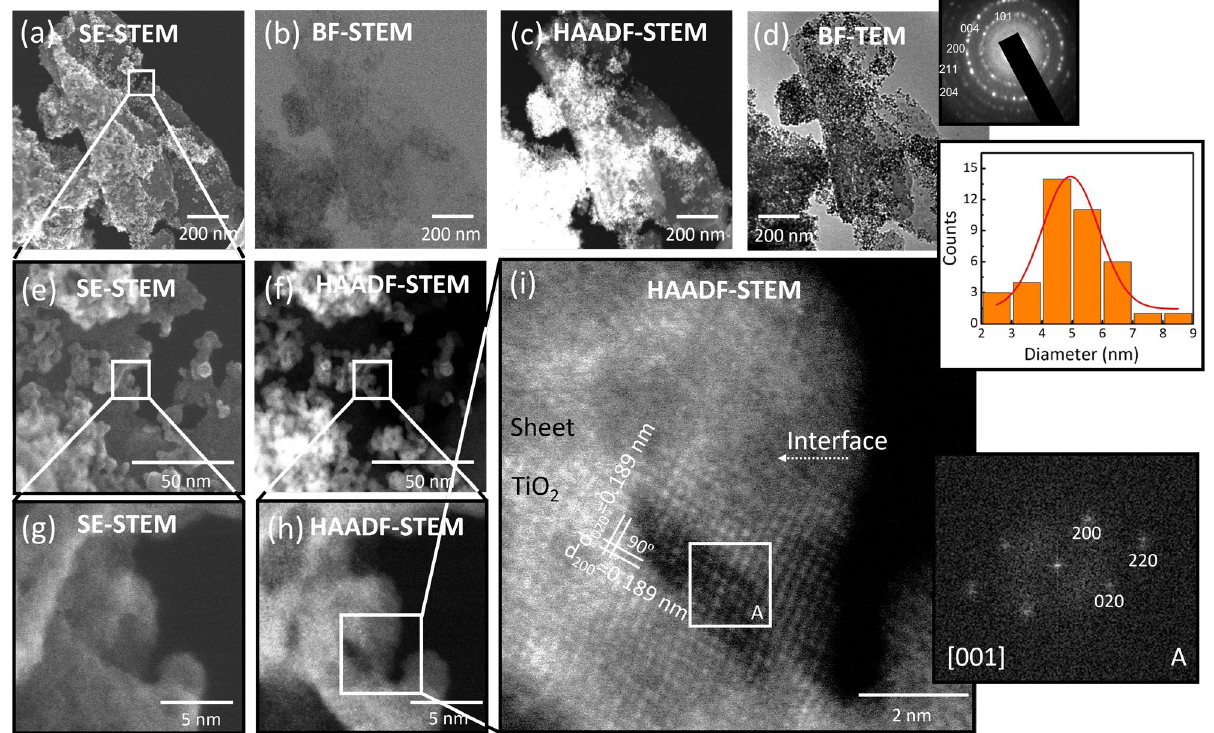
Figure 4 . ( a ) Secondary electron (SE) STEM image of the 30-GCN-T material, ( b ) Bright-field (BF) STEM image of the same area of ( a ), ( c ) HAADF-STEM image of the area in ( a , d ) Bright-field TEM image of the area in ( a ). The insets in ( d ) depict the electron diffraction pattern of TiO 2 nanoparticles with the anatase phase and the particle size distribution of the TiO 2 nanoparticles measured by TEM analyses. ( e , f ) Magnified SE-STEM and HAADF-STEM images of the area analyzed in ( a ), respectively. ( g ) SE-STEM and ( h ) HAADF-STEM image of a TiO 2 nanocrystal attached to the g-C 3 N 4 sheet, and ( i ) atomic-resolution HAADF-STEM image of the area in ( g , h ), where the interface between the TiO 2 nanocrystal and the g-C 3 N 4 sheet is clear. The inset in ( i ) shows the FFT image of the area indicated as A (white